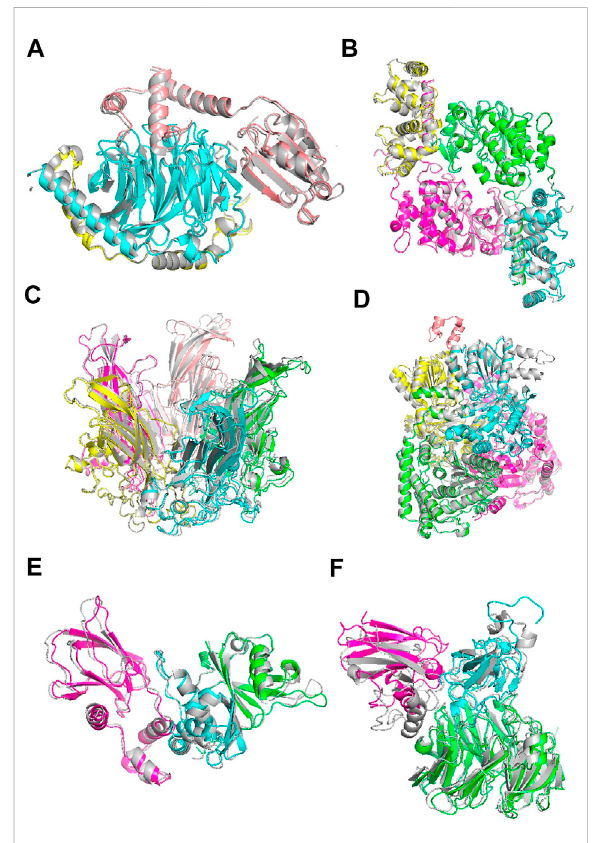
FIGURE 6 Examples of docking models by RL-MLZerD. The native structure solved by experimental method is in grey, the generated models are shown in colors. Each chain is colored in a different color. The best model among the top 5 models is shown. (A) , Transducin Beta-Gamma complex and Phosducin, PDB ID: 1A0R. A 3-chain complex. RMSD, 0.87 Å. (B) , Serine/threonine-protein phosphatase 2B catalytic subunit alpha isoform and calcineurin subunitBtype1,PDBID:3LL8.A4chaincomplex.RMSD1.31 Å (C) , Capside protein Vp1, PDB ID: 1CN3. A 5-chain complex. RMSD, 1.42 Å. (D) , Pyruvate dehydrogenase E1 component subunit alpha and beta and Dihydrolipoyllysine-residue